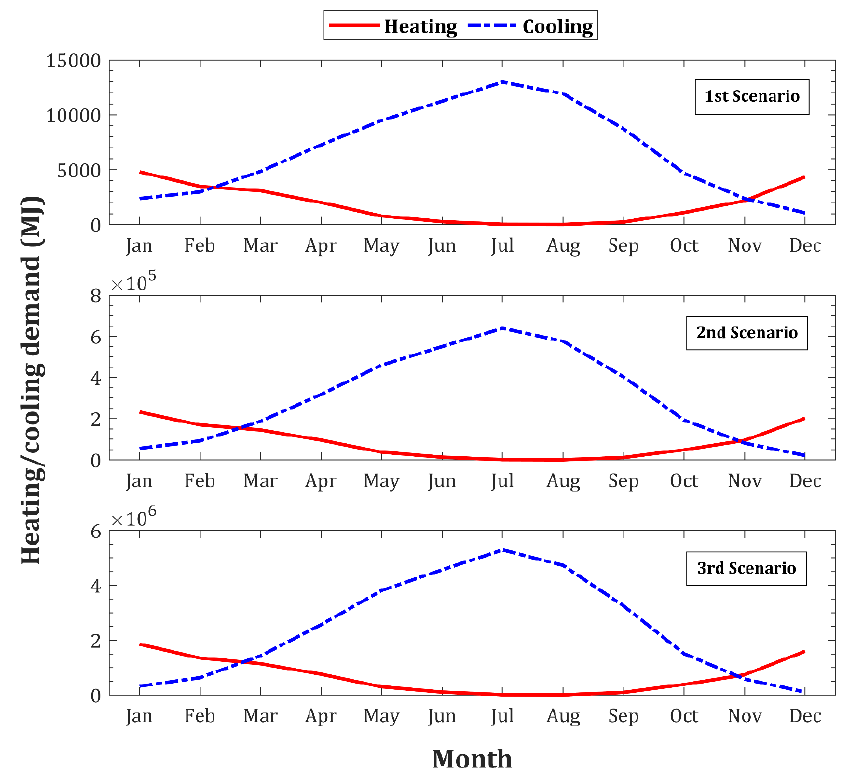
Figure 11. Monthly heating and cooling demands of the greenhouses.